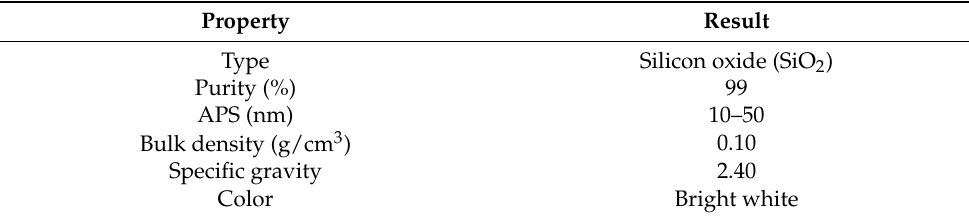
Table 2. Physical properties of nano-SiO 2 [24,30].